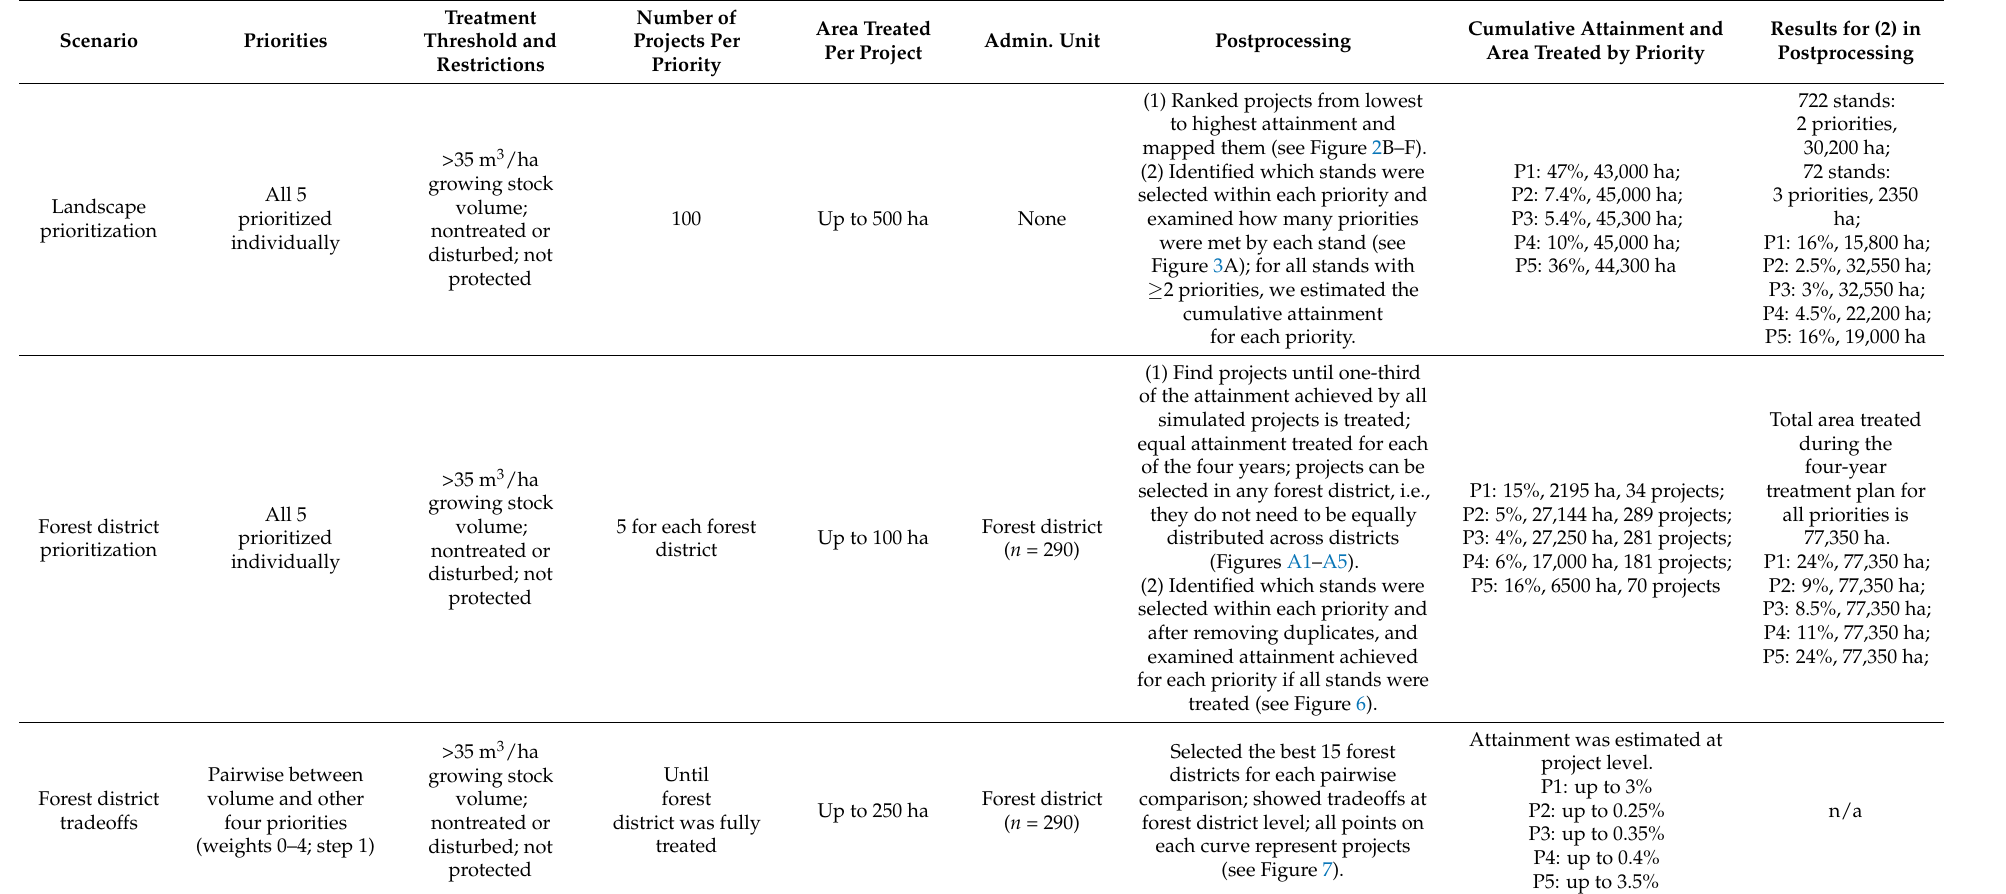
Table A1. Run parameters used in ForSys, including the postprocessing approach and results for each prioritization